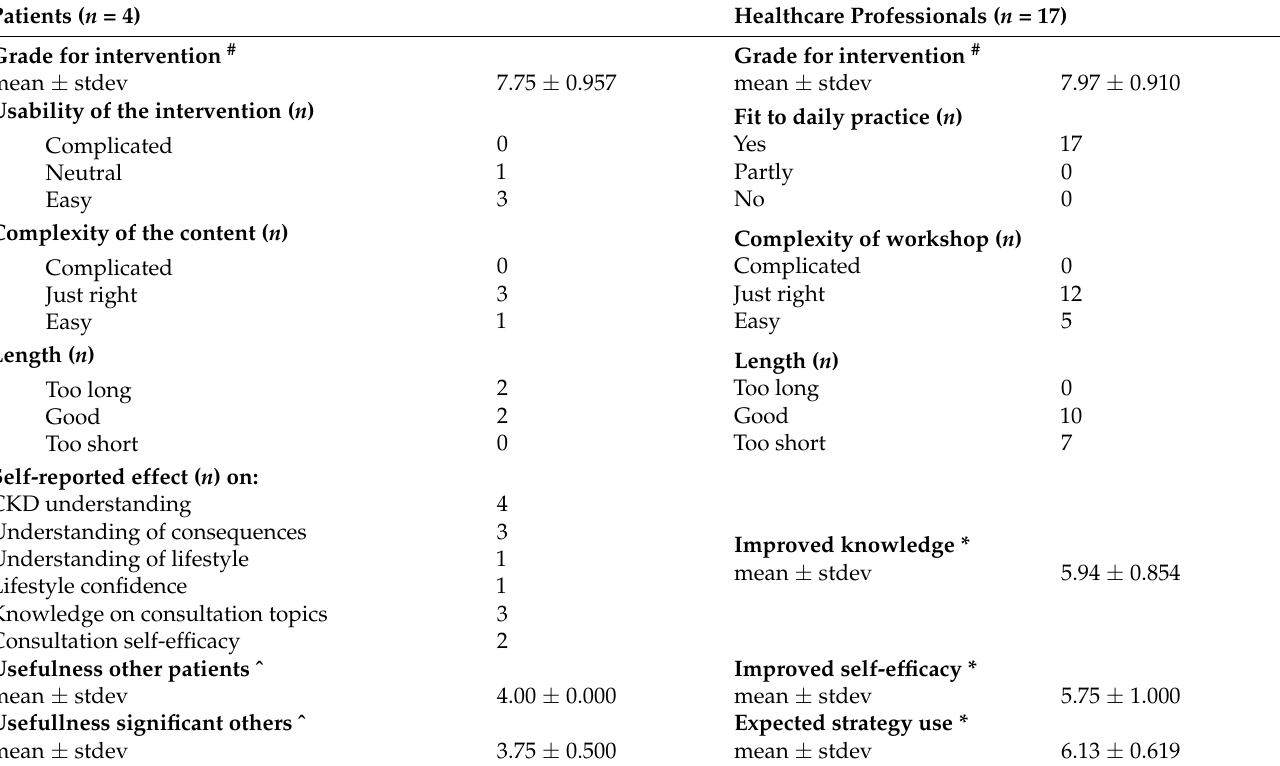
Table 3. Evaluation of the intervention with patients and healthcare